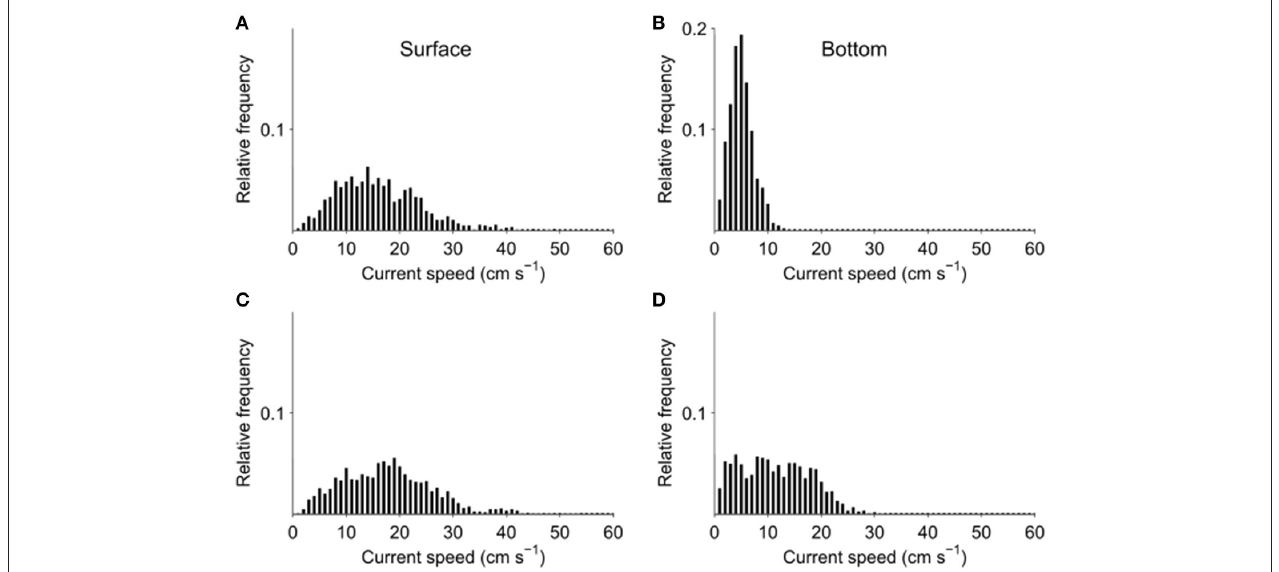
FIGURE 12 | Statistical distribution, for the entire simulation period, of simulated water current speeds at 5m depth (A,C) and the bottom (B,D) for sample points 2 (A,B) and 9 (C,D) at location 2 (eastern cage array II; Figure 8